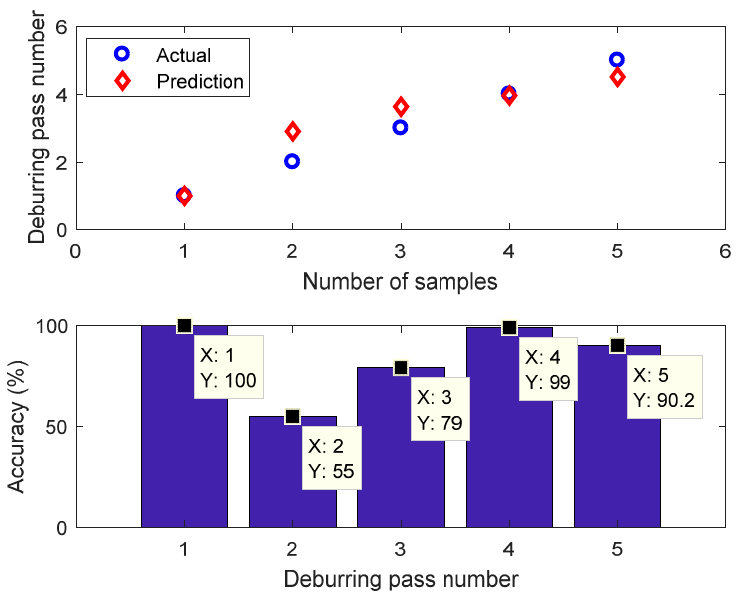
Figure 23. FIS Sugeno prediction.